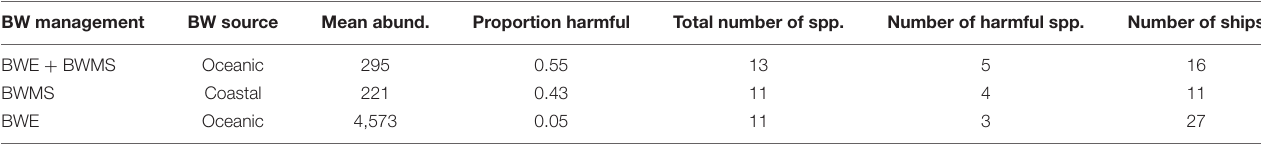
TABLE 2 | Average abundance (cells mL − 1 ship-1) and cumulative number of total and harmful phytoplankton species (spp.) observed in ballast water samples from ships using different ballast water management strategies: ballast water exchange (BWE), BWMS alone, or combining BWE + BWMS. BW management